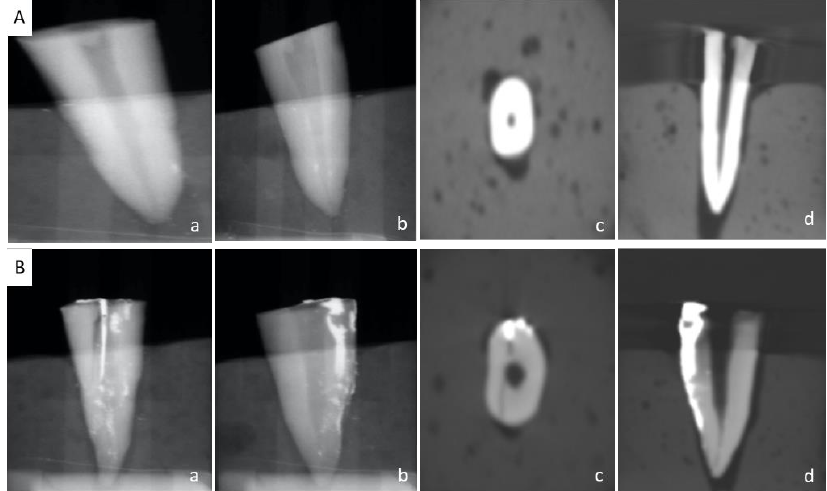
Figure 1. Detection of vertical root fracture in control and experimental groups. ( A ) Control group (( a ), straight PAR; ( b ), angled PAR; ( c ), axial CBCT; ( d ), sagittal CBCT). ( B ) Experimental group (( a ), straight PAR; ( b ), angled PAR; ( c ), axial CBCT; ( d ), sagittal CBCT). Table 1. Questionnaire.